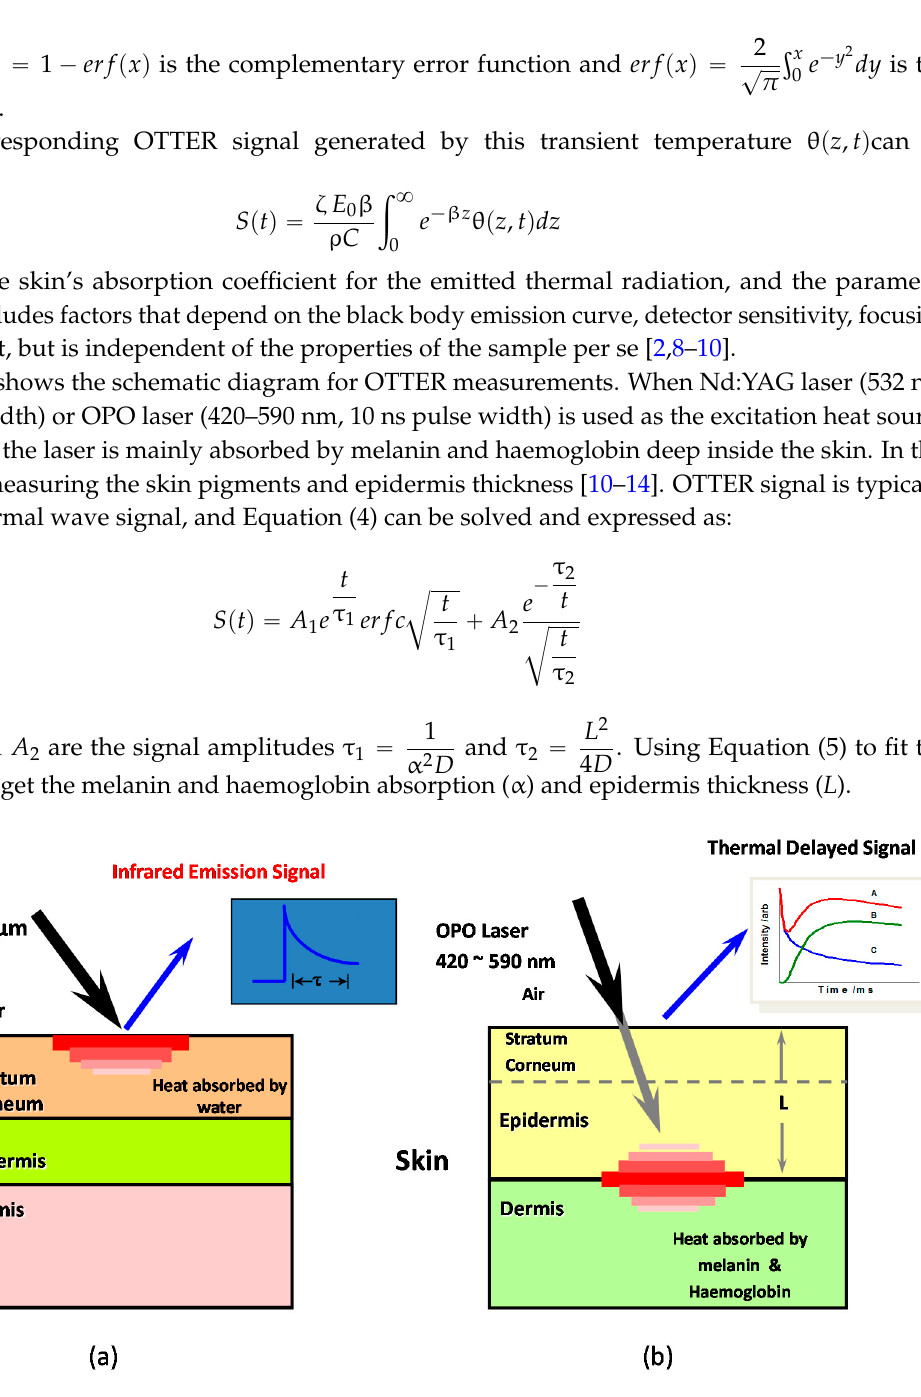
Figure 1. The schematic diagram for OTTER hydration measurements ( a ) and skin pigments measurements ( b ).